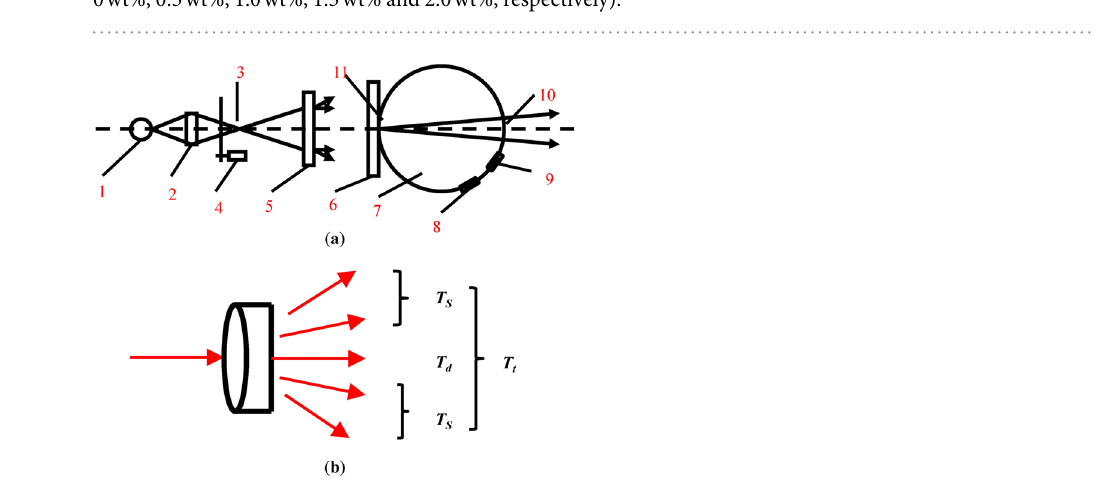
Figure 1. ( a ) Optical system of the Transmittance-Haze testing instrument: (1) source (2) condenser (3) aperture (4) modulator (5) lens (6) sample (7) integrating sphere (8) photocell (9) reflectance standard (10) emergent window